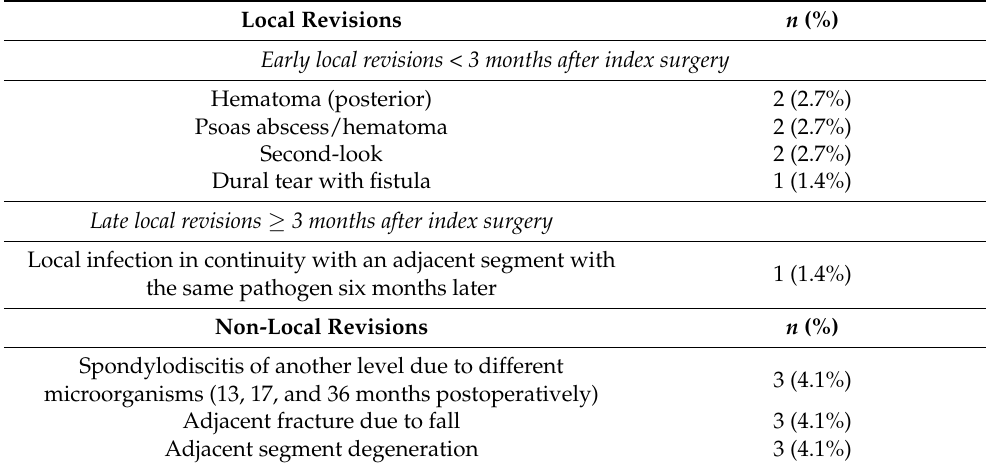
Figure 6. Sixty-two-year-old male patient with severe destructive spondylodiscitis L4/5. Preoperative CT-Scheme and lateral X-ray ( a , b ). Three-month follow-up radiograph ( c , d ). X-ray and CT scan one year after surgery showing anterior, intervertebral pseudarthrosis with stable posterior implants ( e – h ). Table 6. Early and late local and non-local complications requiring revisions to the lumbar